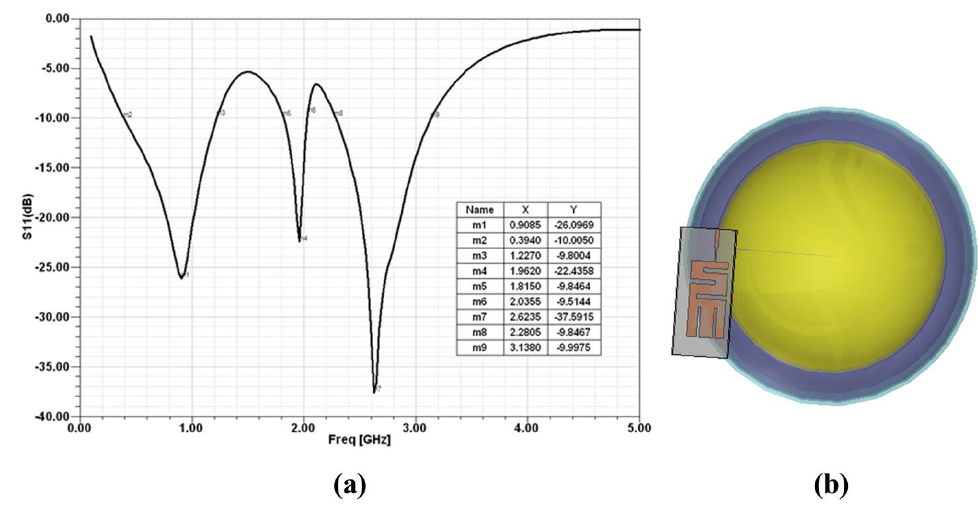
Figure 4. Model HFSS of Layered sphere irradiated by a patch antenna. (a) Return loss. (b) Model with SAR measurements.